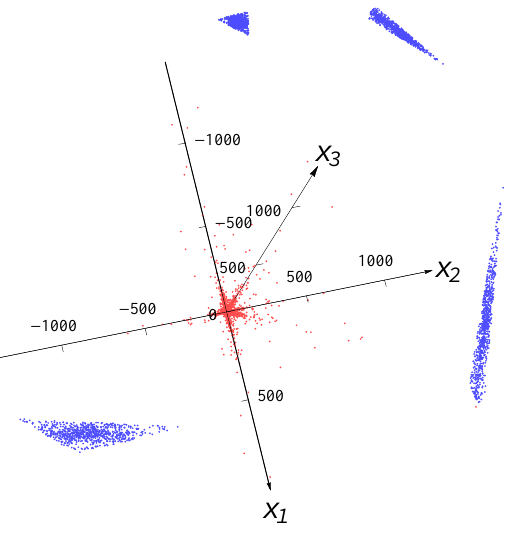
Figure 8. Sample from four Student t distributions with 10% artificial